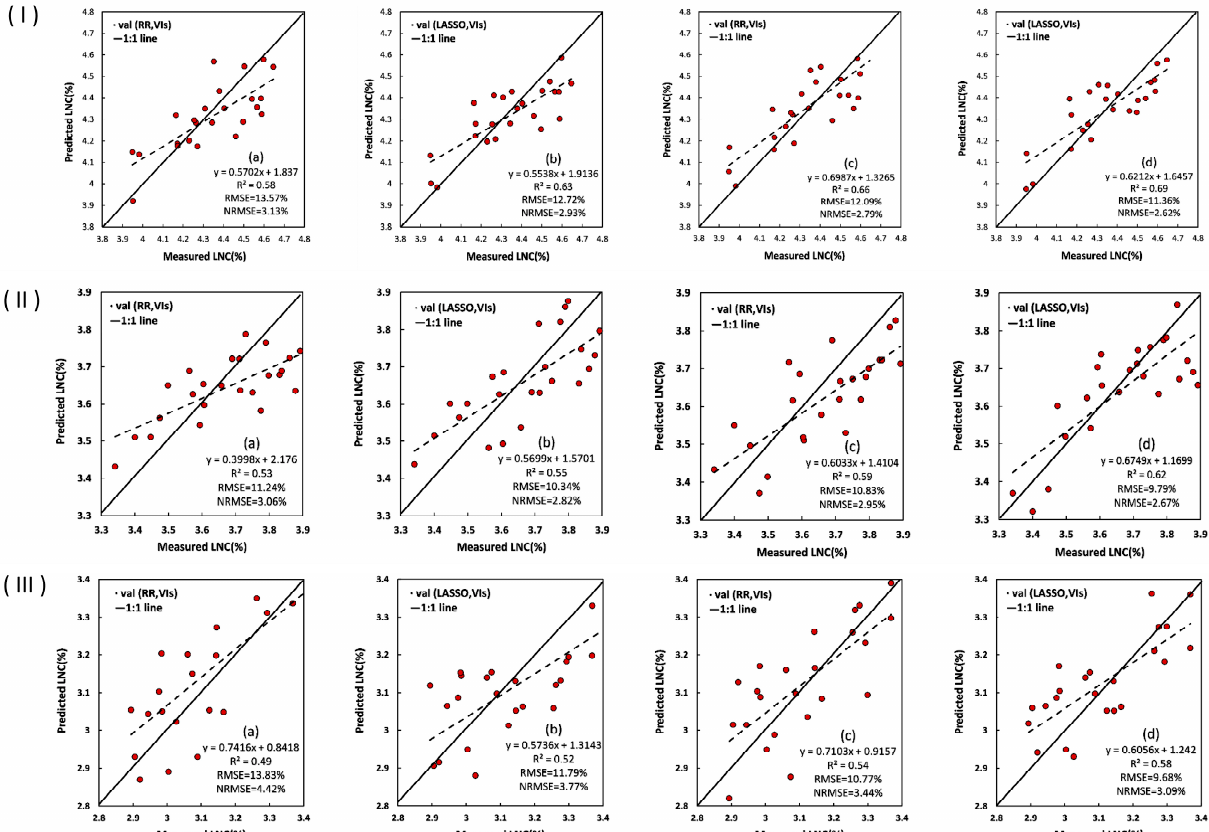
Figure 12. Predictive performance for each stage. ( I – III ) represent the Rice Jointing, Booting and Filling stages, respectively. ( a ) Using RIDGE Regression for denoised original multispectral images; ( b ) Using LASSO Regression for denoised original multispectral images; ( c ) Using RIDGE Regression for denoised fusion images; ( d ) Using LASSO Regression for denoised fusion images.